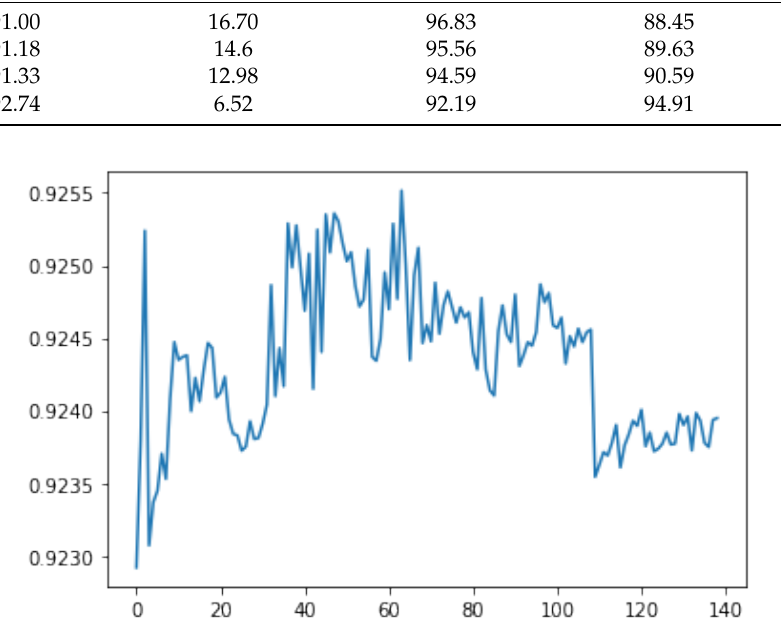
Figure 2. F1-score varies with training epochs for the